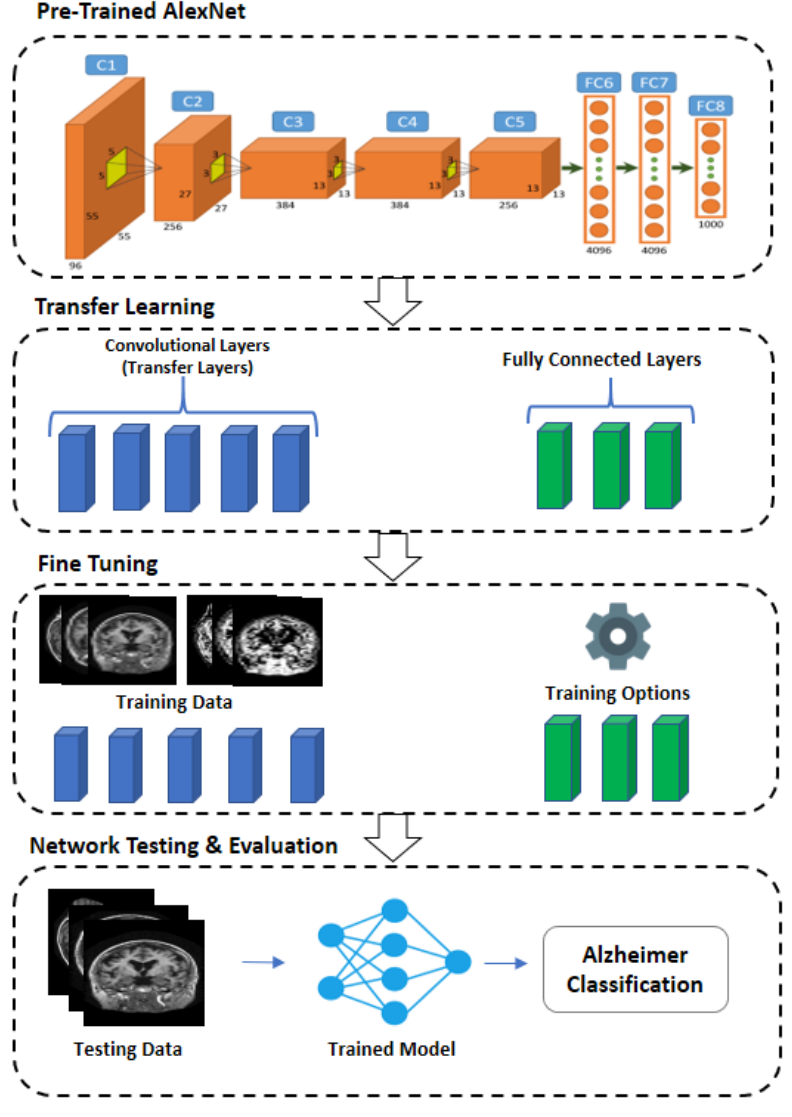
Figure 1. Proposed Figure 1. Proposed Methodology.